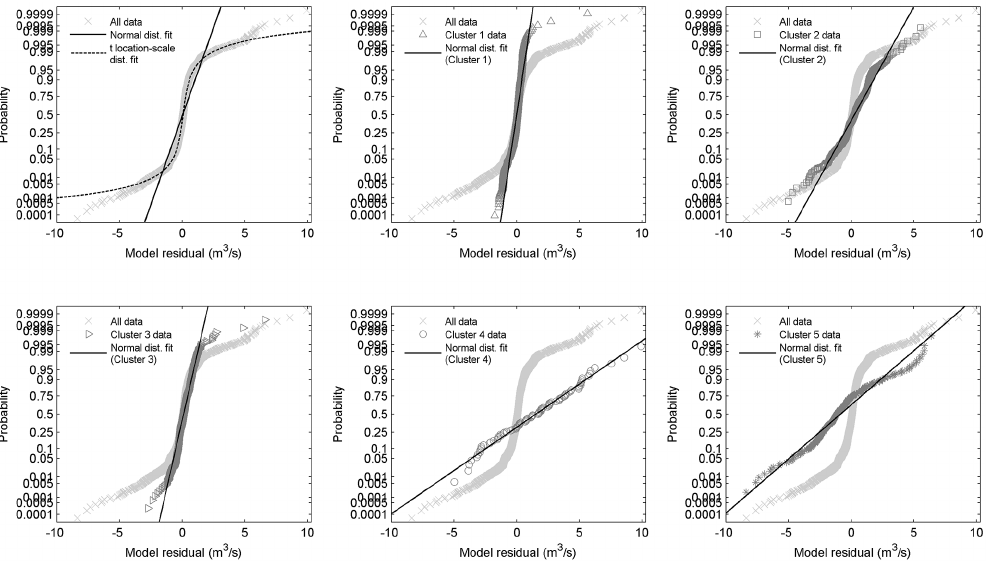
Figure 7. Probability plots for model residuals (during training) for the Brue catchment: comparison of the two fitted distributions: normal vs. t location-scale distribution (top left), and the